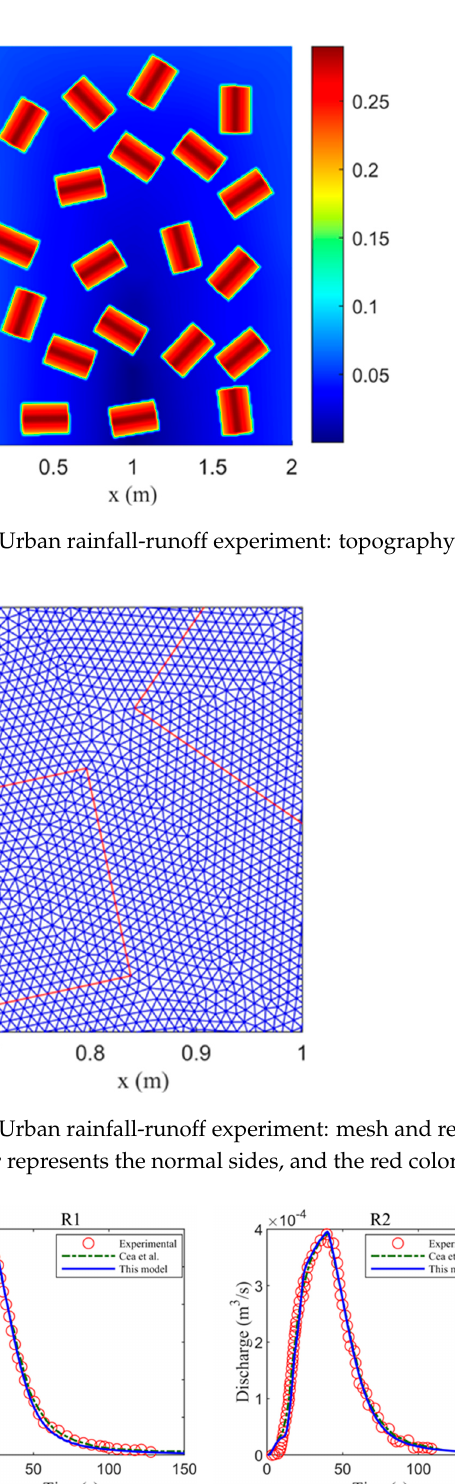
Figure 10. Urban rainfall-runoff experiment: simulated and measured outlet discharges.